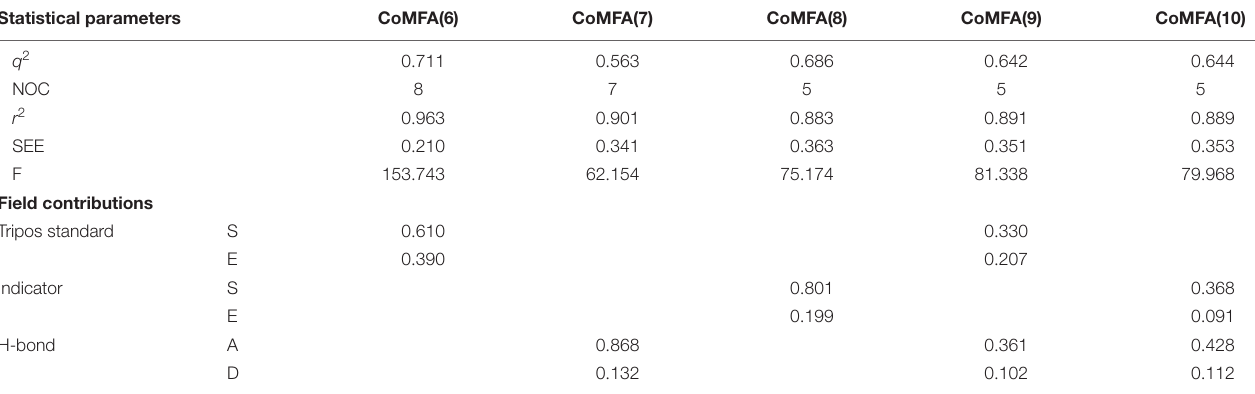
TABLE 1 | Detailed results of CoMFA models after the application of Region Focusing .